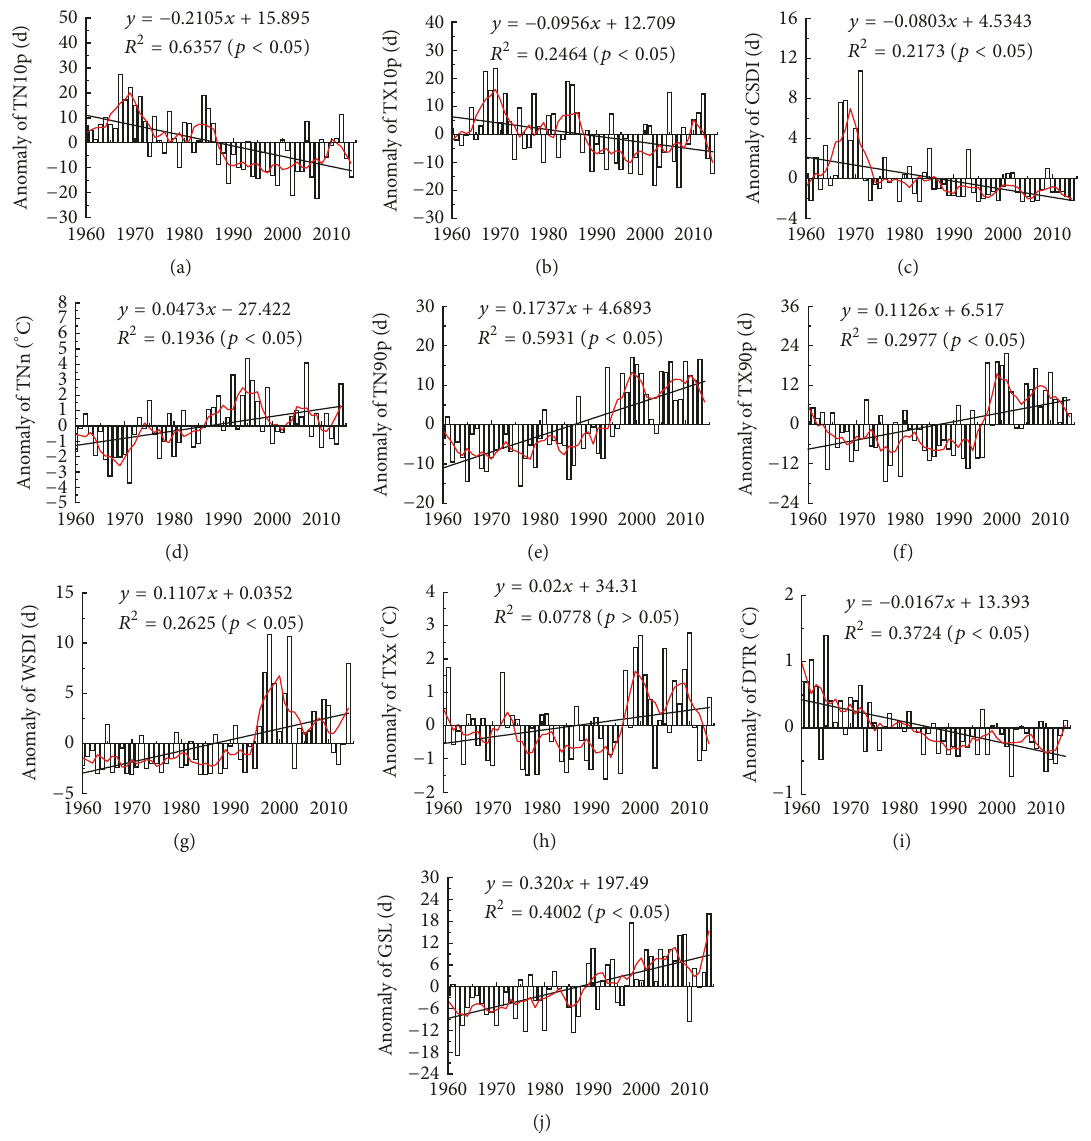
Figure 6: Anomaly of extreme temperature indices curves across the BTSSR (1960–2014). The black line represents the linear trends for (a) TN10p, (b) TX10p, (c) CSDI, (d) TNn, (e) TN90p, (f) TX90p, (g) WSDI, (h) TXx, (i) DTR, and (j) GSL. The redline represents the 5-year moving